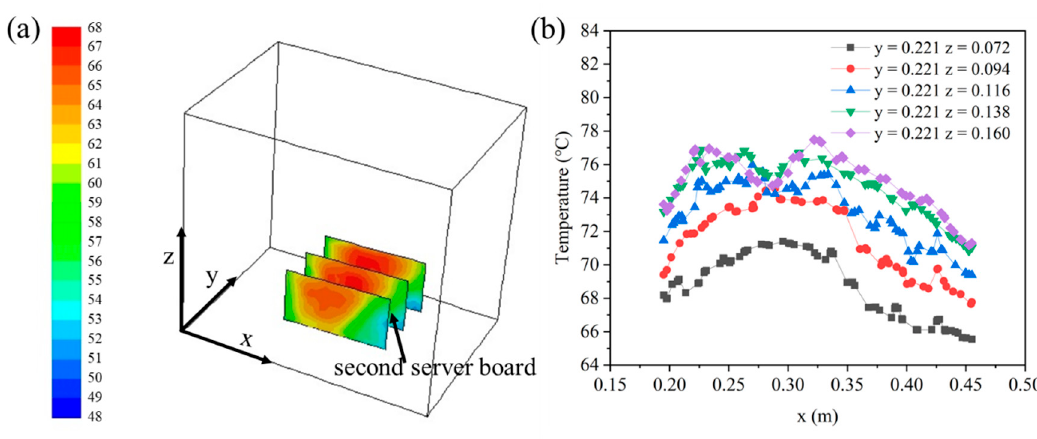
Figure 8. ( a ) Thermal map and ( b ) temperature distribution of the CPU server wallboard.